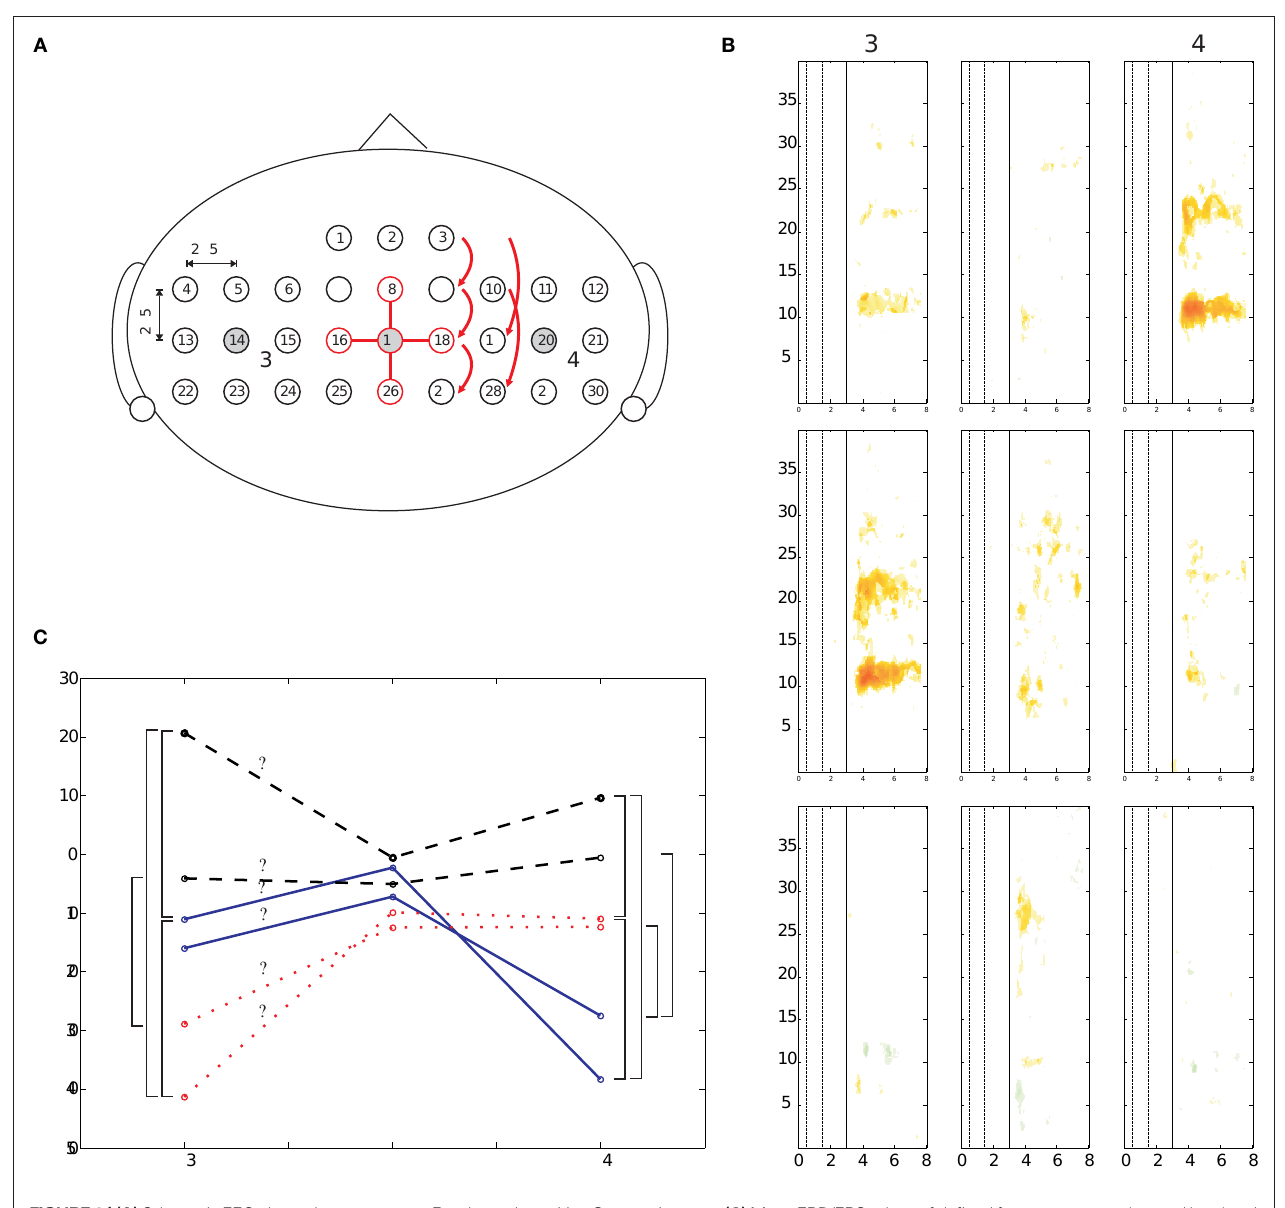
Figure 2 | (A) Schematic EEG electrode arrangement. For electrode position Cz (#17) the required electrodes for the orthogonal source derivations are highlighted. (B) Median ERD/ERS maps for C3, Cz, and C4 and for three types of motor